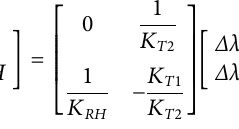
Frontiers in Sensors |